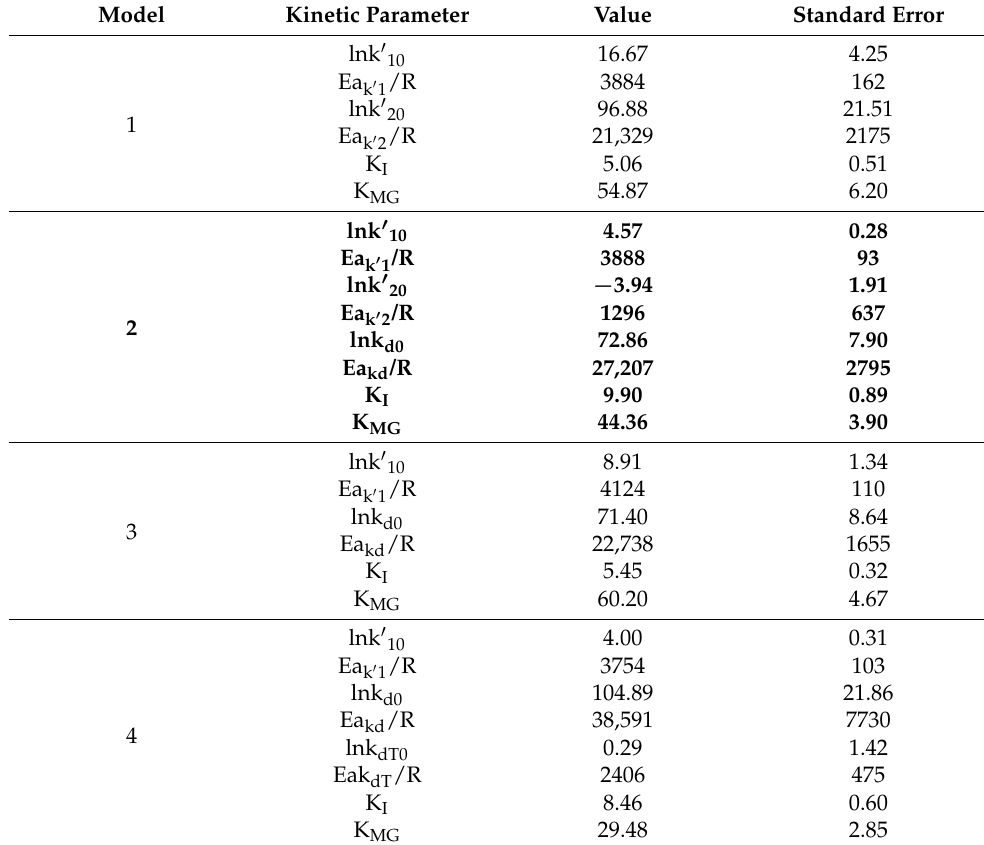
Table 5. Parameter values, with standard error, for each of the proposed kinetic models of glycerol esterification with ibuprofen for the anhydrous L-L-S system with toluene as apolar cosolvent. The selected kinetic model is highlighted in bold font.